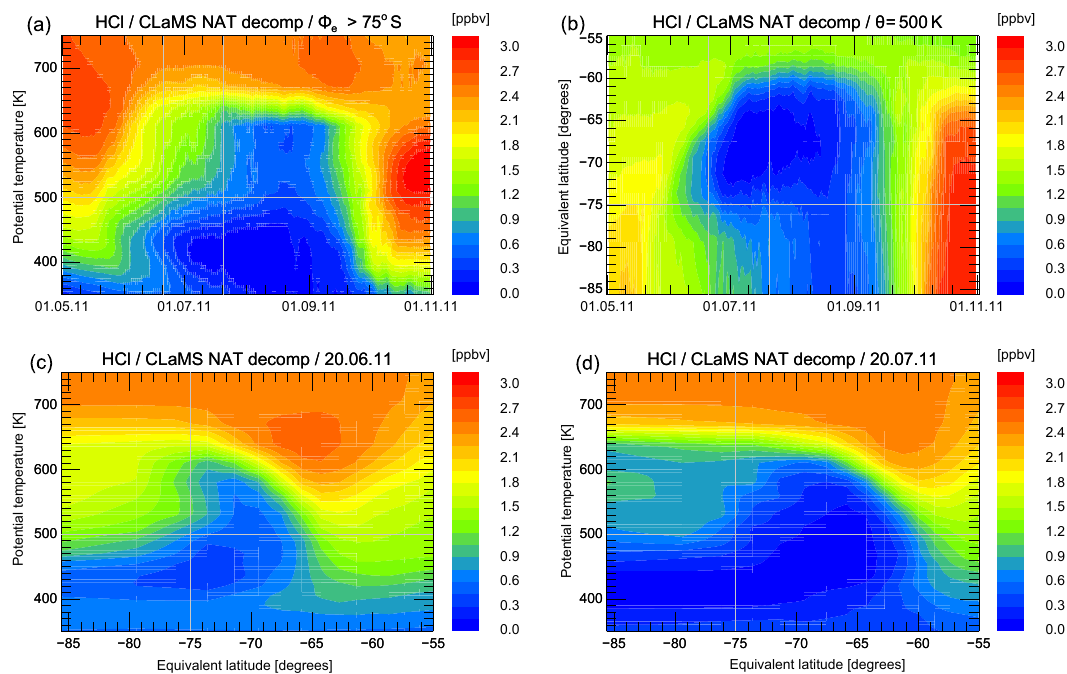
Figure 13. CLaMS simulation results for HCl of the sensitivity NAT decomp simulation averaged in equivalent latitude/potential temperature space displayed as in Figs. 2 and 3.